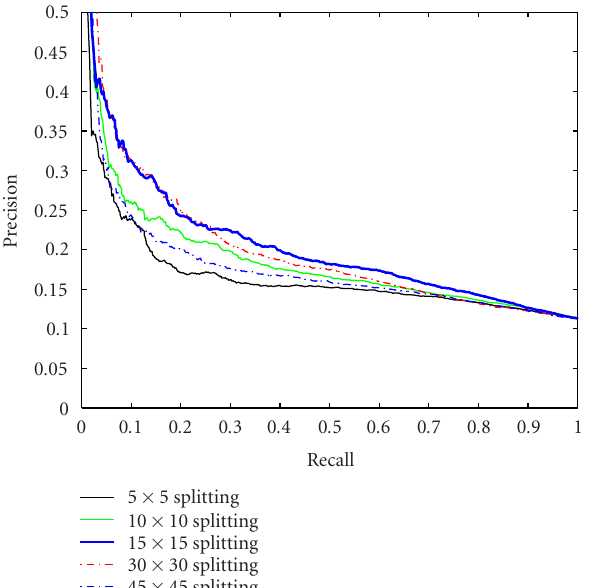
Figure 7: Precision/recall curves for various splittings using our spatio-colorimetric signature (landscape category).